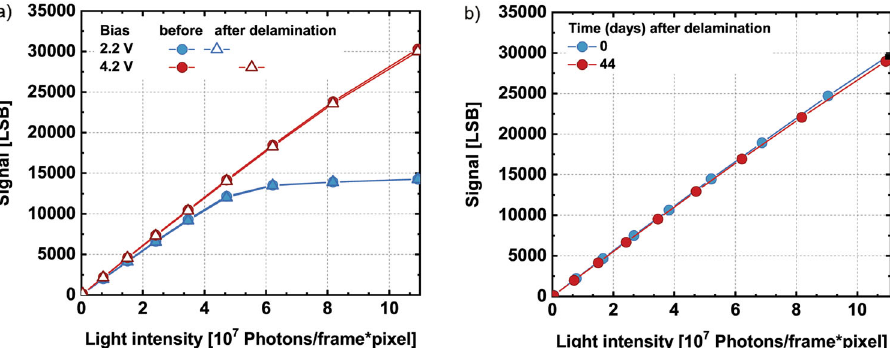
Fig. 5 Flexible array characteristics. a Light response (least signi fi cant bits, LSB) vs. impinging light intensity for the image sensor on foil still on the glass carrier (closed symbols) and after delamination (open symbols) for two different photodiode bias voltages. b Long-term stability of image sensor on foil just after delamination (black, t = 0), and after 44 days (red, t = 44) in